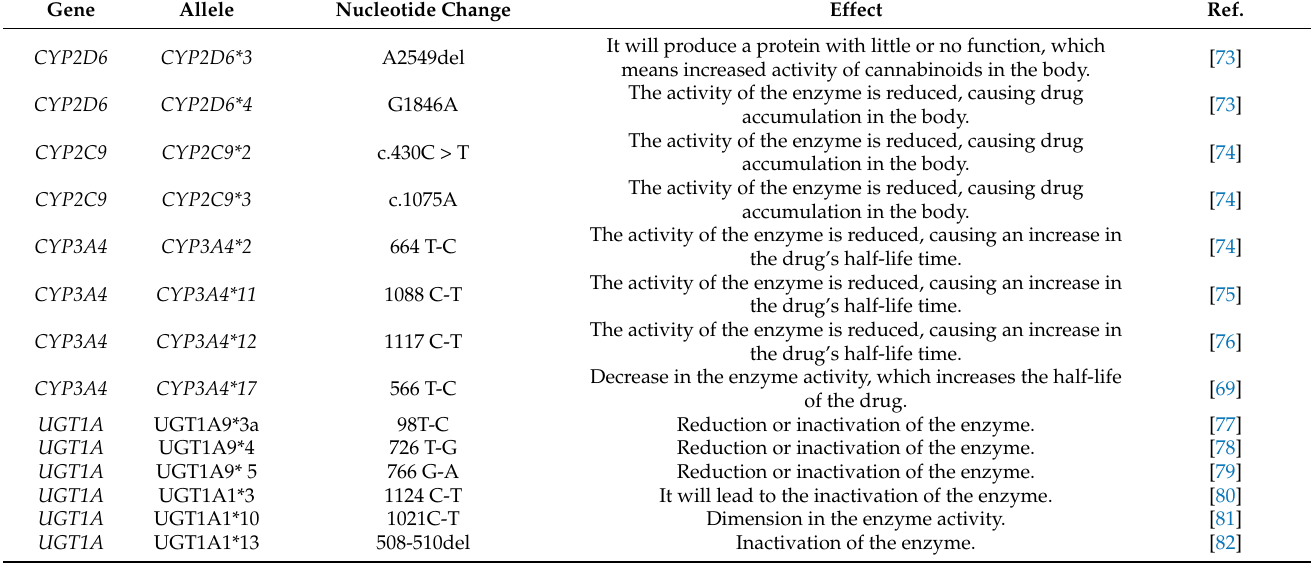
Table 3. Various alleles and their relation to the metabolizing enzyme